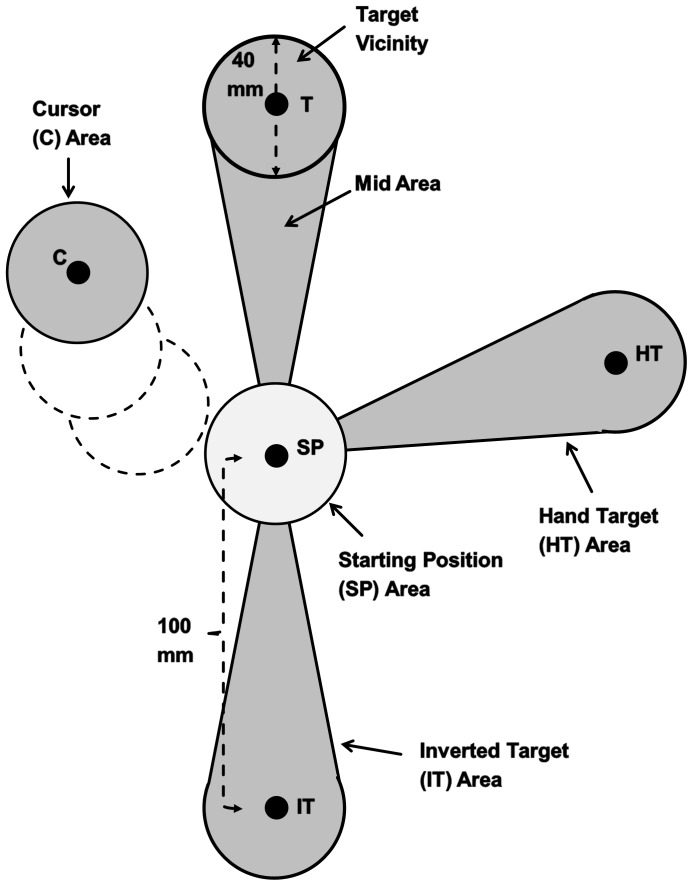
Different gaze areas used for analysis of gaze locations.Five black dots indicate the starting position (SP), the target (T), the hand target (HT), the inverted target (IT), and the cursor (C) positions. The HT position is the hand location that would bring the cursor to the target under the rotated visual feedback (example shown for the 75° rotation). The IT position is the 180° inverted location of the target. The starting position (SP) area, the cursor (C) area, and the target vicinity have a circular shape. The mid area is an area between the SP and target vicinity. The hand-target (HT) area and the inverted-target (IT) area have the same shape as the combined area of the target vicinity and the mid area.